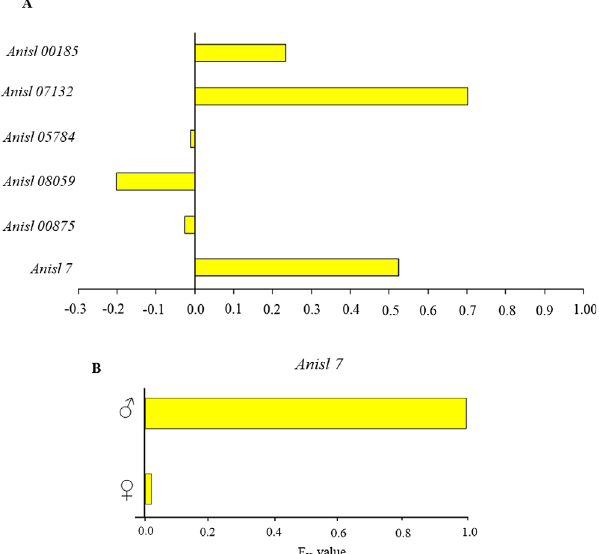
Figure 1. (A) F IS calculated at the six microsatellite loci among the eight studied in A. berlandi . Two loci (i.e. Anisl 00314 and Anisl 10535 ) were not included because they were found to be monomorphic. Negative values indicate heterozygous excess, while positive values indicate homozygous excess from that expected under Hardy – Weinberg Equilibrium (HWE); (B) F IS in male and female specimens of A. berlandi at the sex-linked locus Anisl 7 .